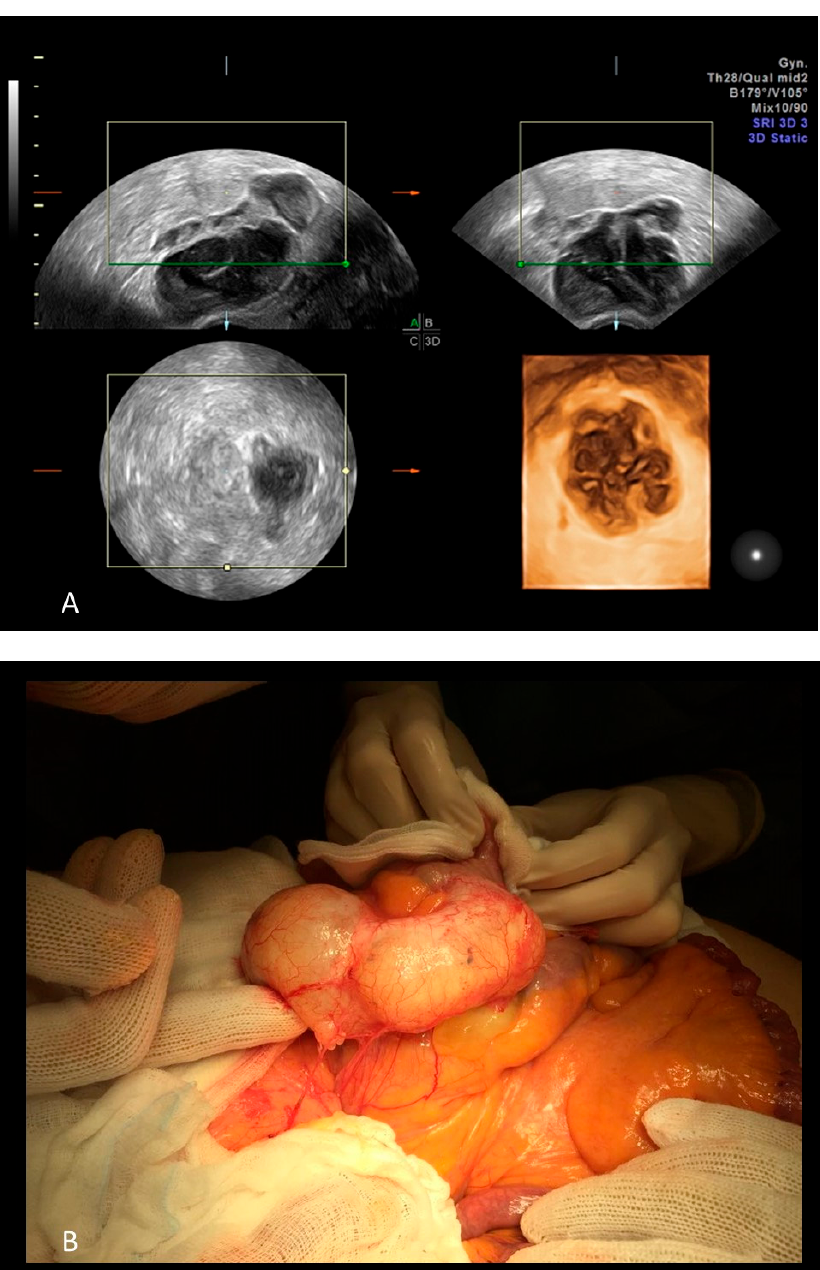
Figure 7. A three-dimensional rendering of a mucocele of 96 × 46 × 20 mm in an 80-year-old woman ( A ) and the same mucocele at surgery ( B ).